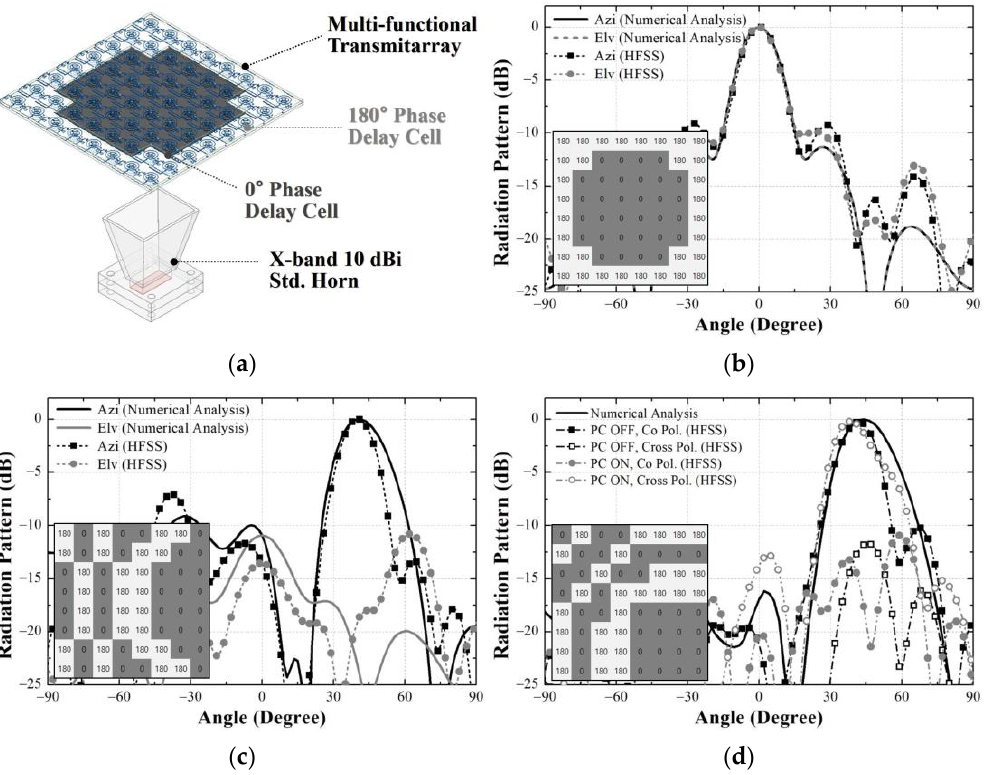
Figure 5. Simulated results of proposed 8 × 8 transmitarray (F/D = 0.64): ( a ) Simulation model (HFSS); ( b ) Broadside beam (V Pol.); ( c ) 45° steered beam with PC OFF state (φ = 0°); ( d ) 45° steered beam (φ = 45°) under the ON and OFF state of PC.